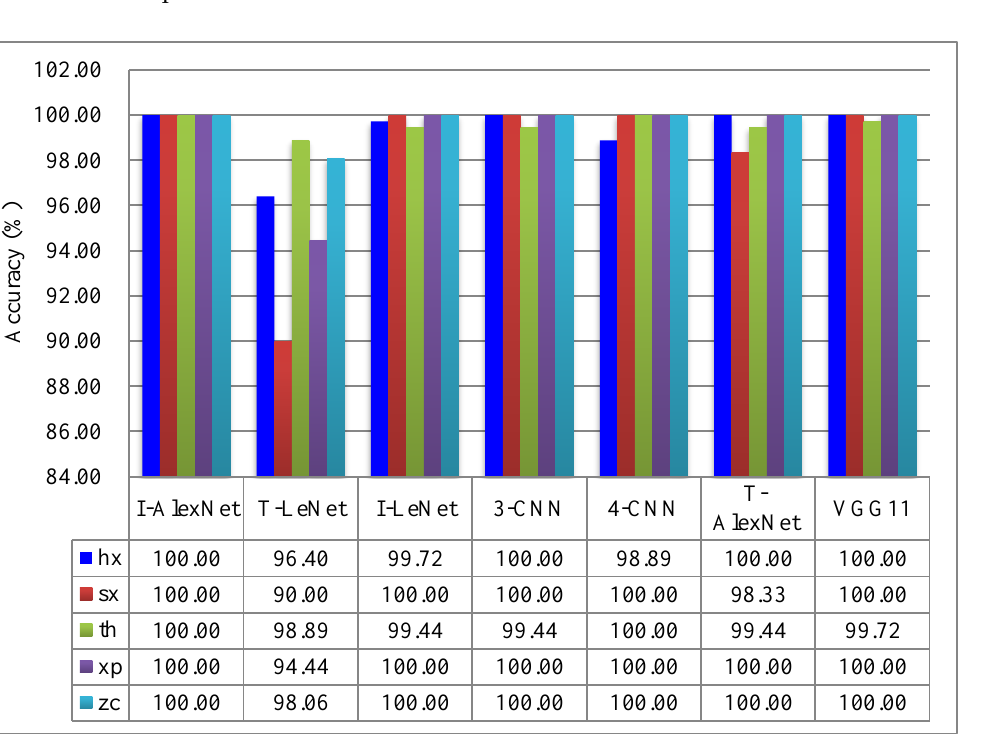
Figure 24. Histogram of accuracy of different CNN models for each fault type. Table 5. Computational time of different CNN models in one epoch.